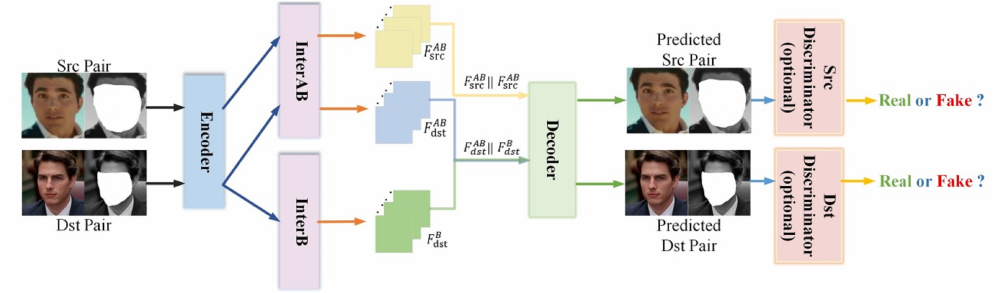
Figure 5. Architecture of DeepFaceLab from